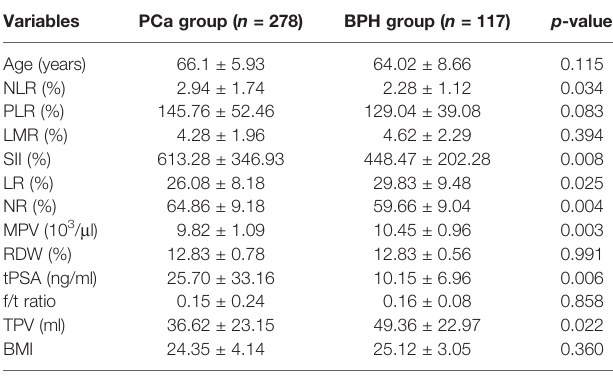
TABLE 3 | Univariable and multivariable analyses for predicting localized prostate cancer.